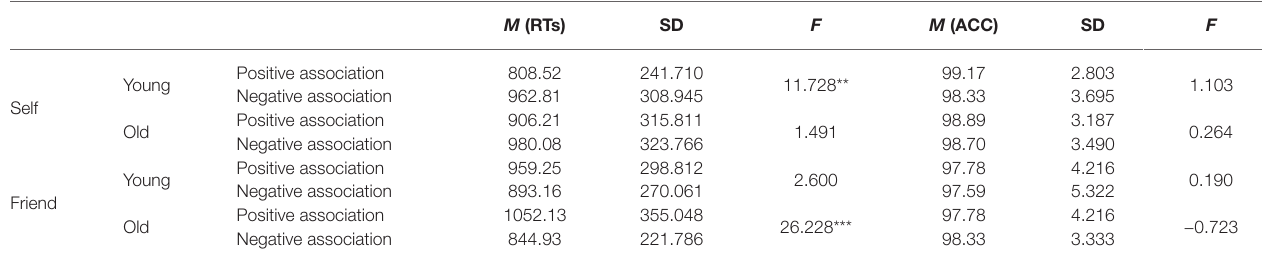
TABLE 2 | The mean (SD) of Experiment 2.